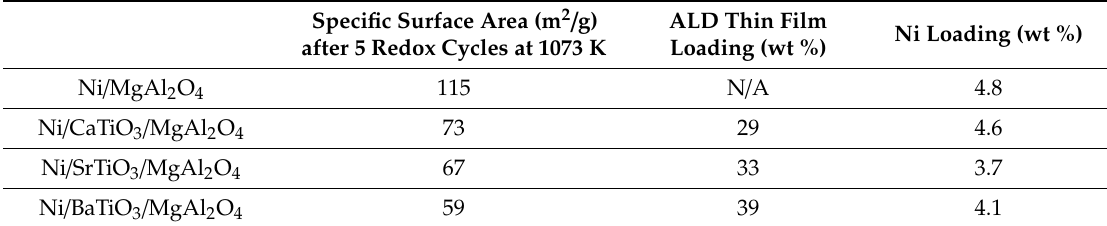
Table 1. Key properties of the samples used in the